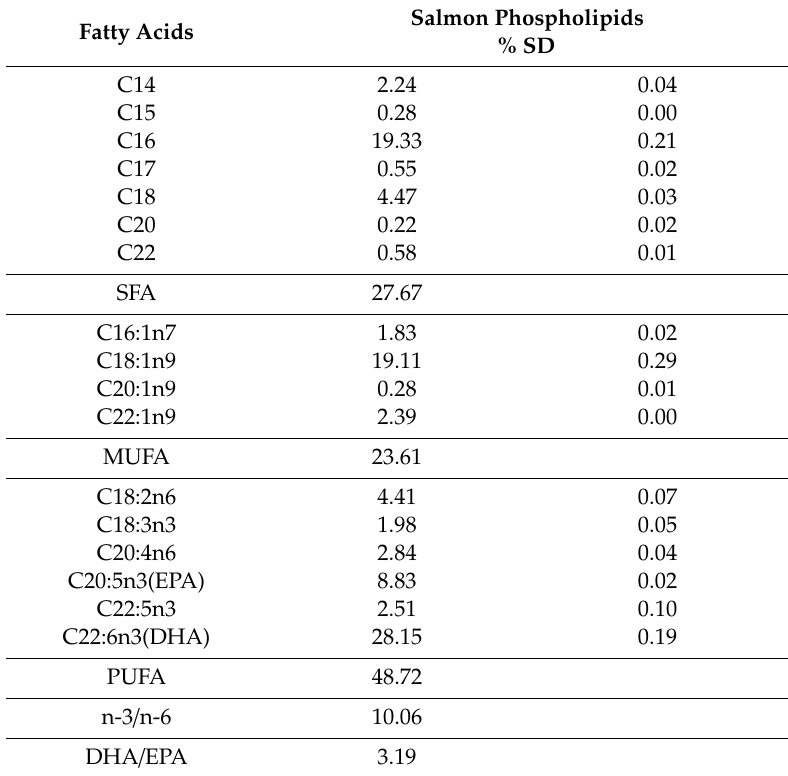
Table 1. Fatty acid compositions, after purification by acetone precipitation, of salmon phospholipids. Fatty